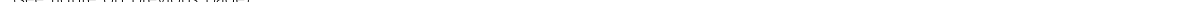
(see fi gure on previous page) Fig. 2 HNRNPD bound to ZHX2 and promoted the ability of VM formation in glioma cells. A Luciferase reporter assay of HEK-293T cells co- transfected with HNRNPD and ZHX2-3 ′ UTR-Wt or ZHX2-3 ′ UTR-Mut at different locus. Data are presented as the mean ± SD ( n = 3, each group). * P < 0.05 vs. HNRNPD + ZHX2-3 ′ UTR-Wt group. B The graph shows ZHX2 mRNA levels at different times treated by ActD in U87 and U251 cells. Data are presented as mean ± SD ( n = 3, each group). ** P < 0.01 vs. HNRNPD( − )-NC group. C The graph shows nascent ZHX2 in U87 and U251 cells. Data are presented as mean ± SD ( n = 3, each group). P > 0.05 vs. HNRNPD( − )-NC group. D Expression levels of ZHX2 mRNA regulated by HNRNPD in U87 and U251 cells. Data are presented as the mean ± SD ( n = 3, each group). * P < 0.05 vs. HNRNPD( − )-NC group. E Expression levels of ZHX2 protein regulated by HNRNPD in U87 and U251 cells. Data are presented as the mean ± SD ( n = 3, each group). * P < 0.05, ** P < 0.01 vs. HNRNPD( − )-NC group. F – H CCK-8 assay, transwell, and three-dimensional culture were applied to evaluate the proliferation,migration, invasion, and tube formation effect of HNRNPD inhibition and ZHX2 overexpression on U87 and U251 cells. Representative images and accompanying statistical plots were presented. The scale bar represents 50 µm. I Protein levels of MMP2, MMP9, and VE-cadherin regulated by HNRNPD and ZHX2 in U87 and U251 cells. Data are presented as the mean ± SD ( n = 3, each group). * P < 0.05, ** P < 0.01 vs. HNRNPD( − )-NC + ZHX2( + )-NC group; # P < 0.05, ## P < 0.01 vs. HNRNPD( − ) + ZHX2( + )-NC group; & P < 0.05, && P < 0.01 vs. HNRNPD( − )-NC + ZHX2( + )